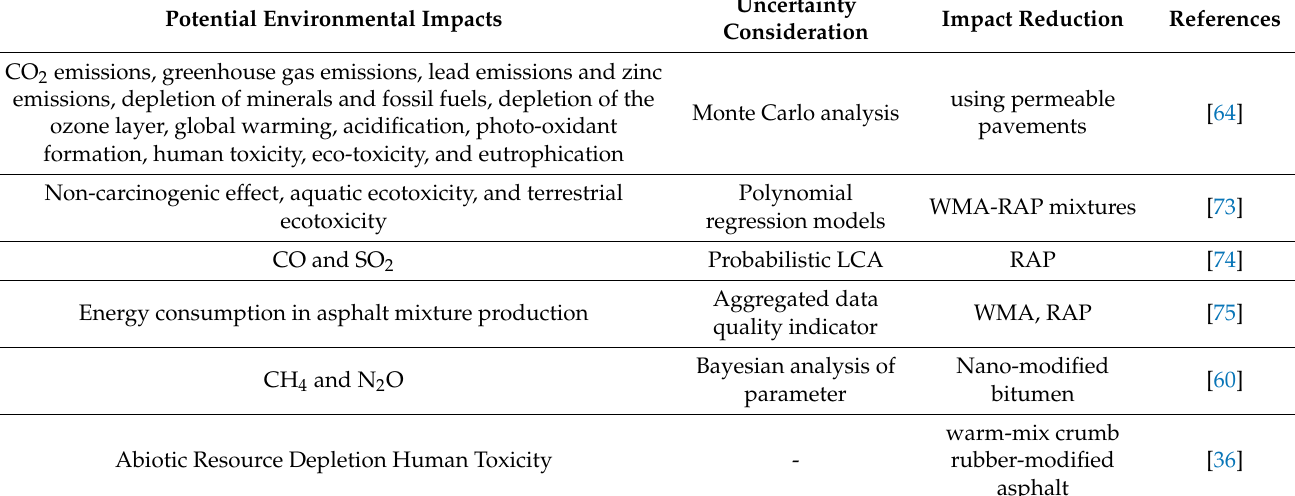
Table 3. Pavement life cycle potential environmental impacts, uncertainty, and impact reduction